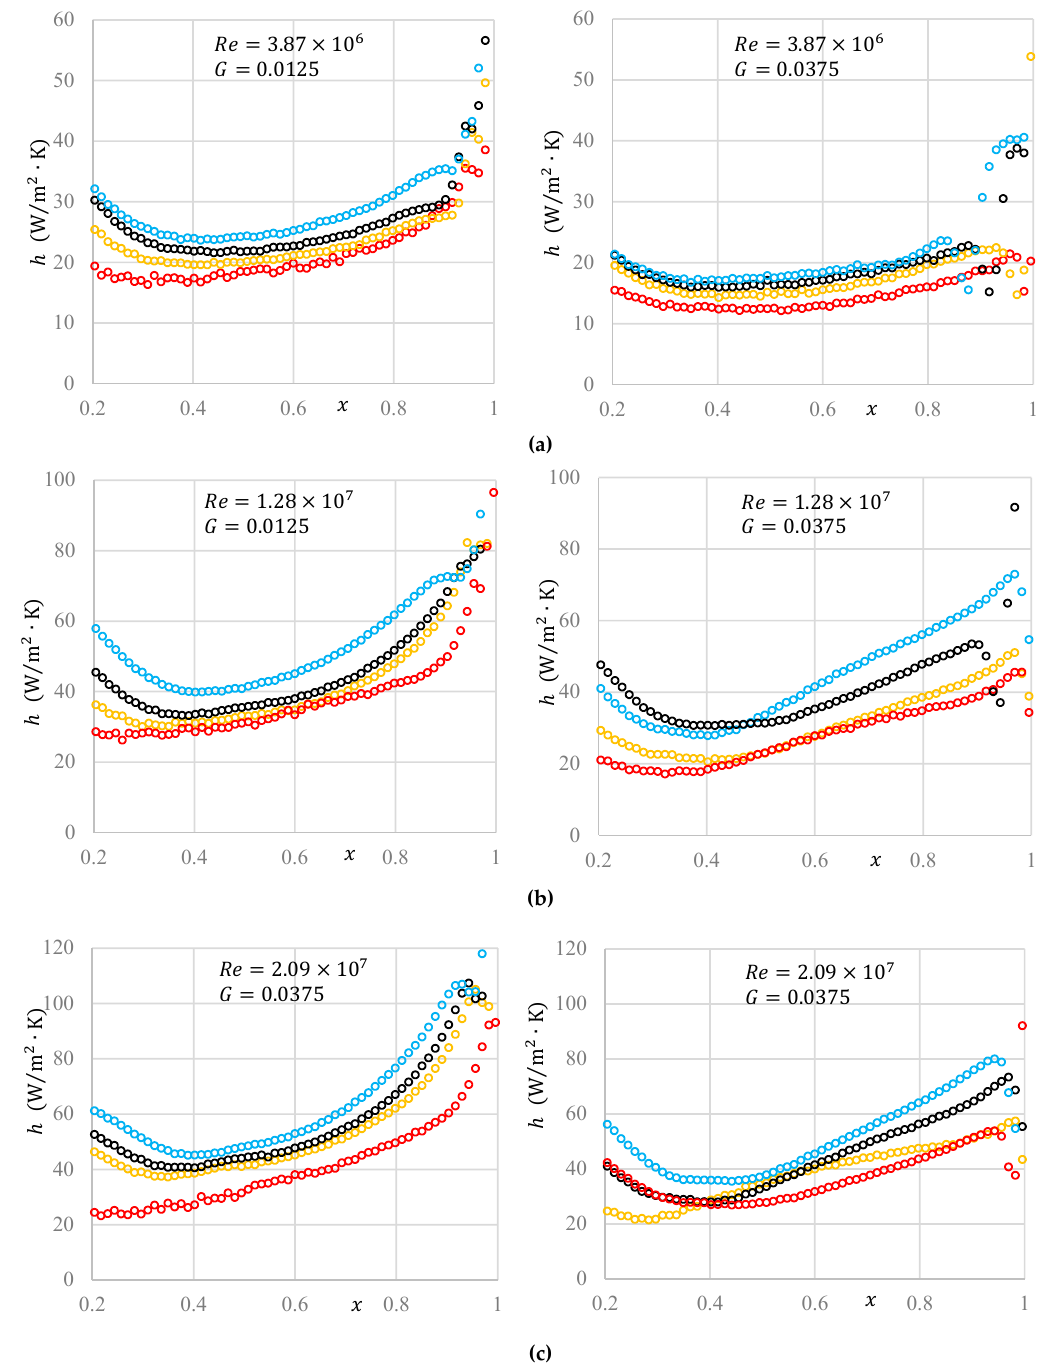
Figure 8. Radial distribution of ℎ from numerical simulations for ( a ) 𝑅𝑒 = 3.87 × 10 (cid:2874) ; ( b ) 𝑅𝑒 = 1.28 × 10 (cid:2875) and ( c ) 𝑅𝑒 = 2.09 × 10 (cid:2875) . 𝑥 : non-dimensional radial coordinated, 𝑥 = (cid:3045) red: 𝐶 (cid:3050) = −1262 ; orange: 𝐶 (cid:3050) = −2525 ; black: 𝐶 (cid:3050) = −3787 ; blue: 𝐶 (cid:3050) = −5050